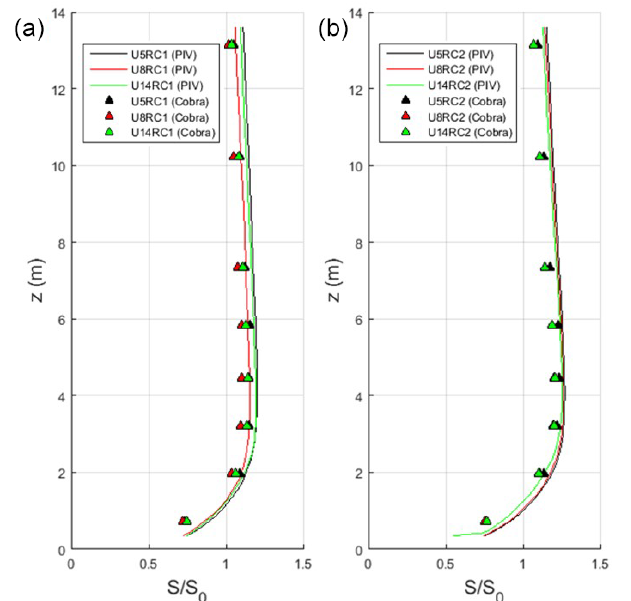
Figure 13. Vertical profiles of speed-up ratio from WindEEE PIV and Cobra probe at M6 for (a) RC1 and (b)